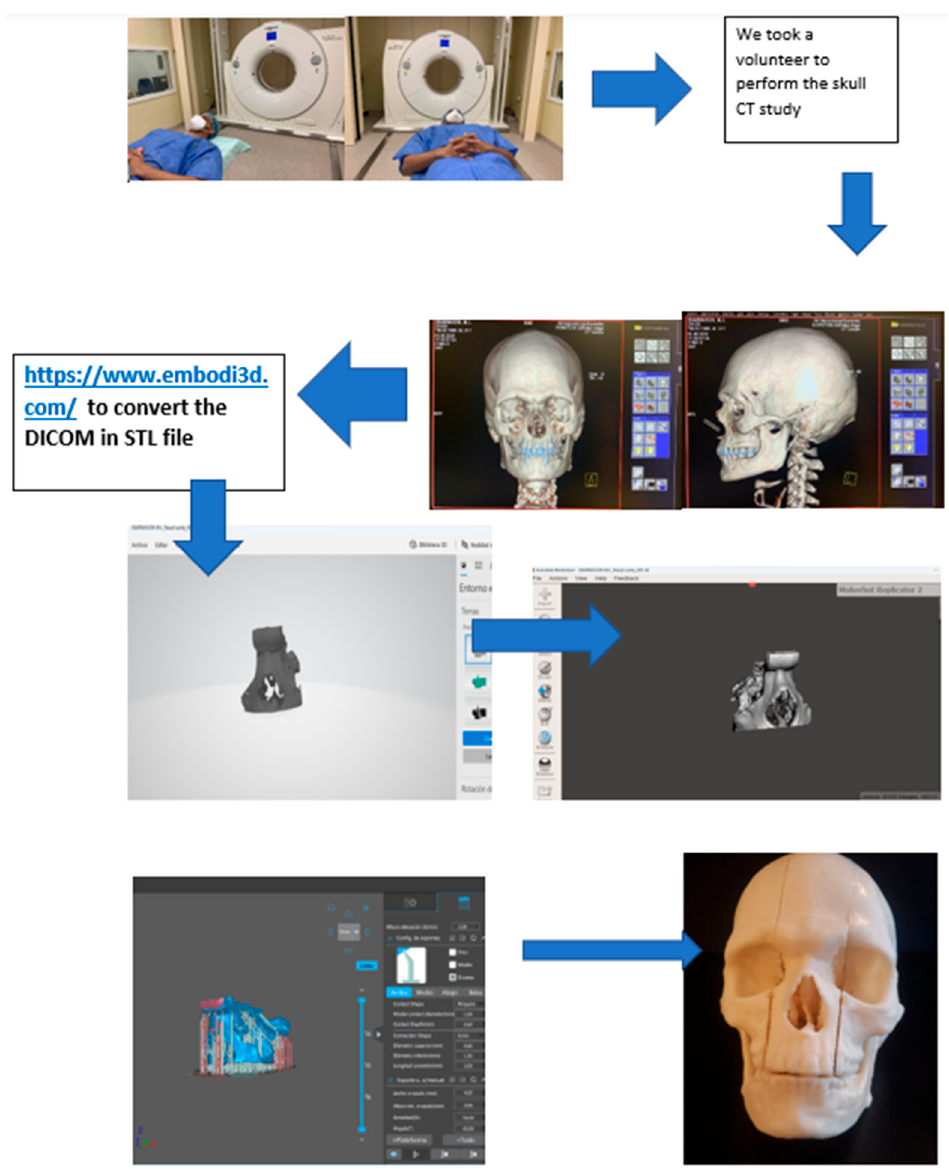
Figure 1. Step 1: perform a CT or MRI scan. Step 2: transform the DICOM files into STL files on a free website (https://www.embodi3d.com (accessed on 25 December 2022)); this can take up to 1 h depending on the DICOM file numbers. Step 3: open the STL files with the Meshmixer program for final processing, repair any errors, and add or remove items. Step 4: open the files with Chitubox for the 3D printer and make the support. Step 5: after the printing process, the phantom is ready.